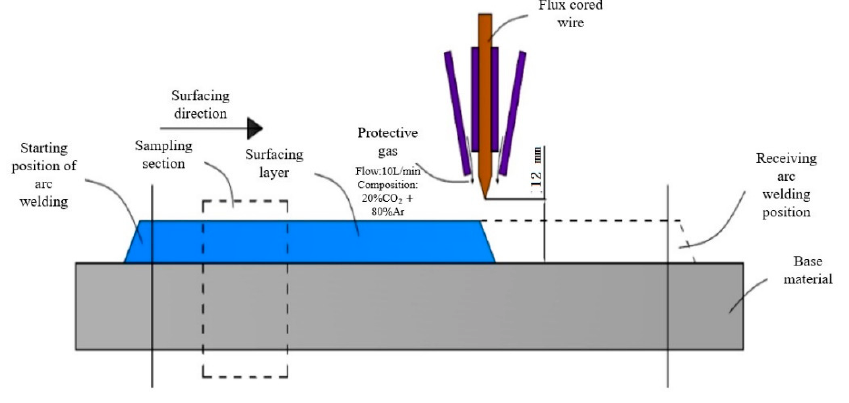
Figure 1. Schematic diagram of H13 steel surfacing.